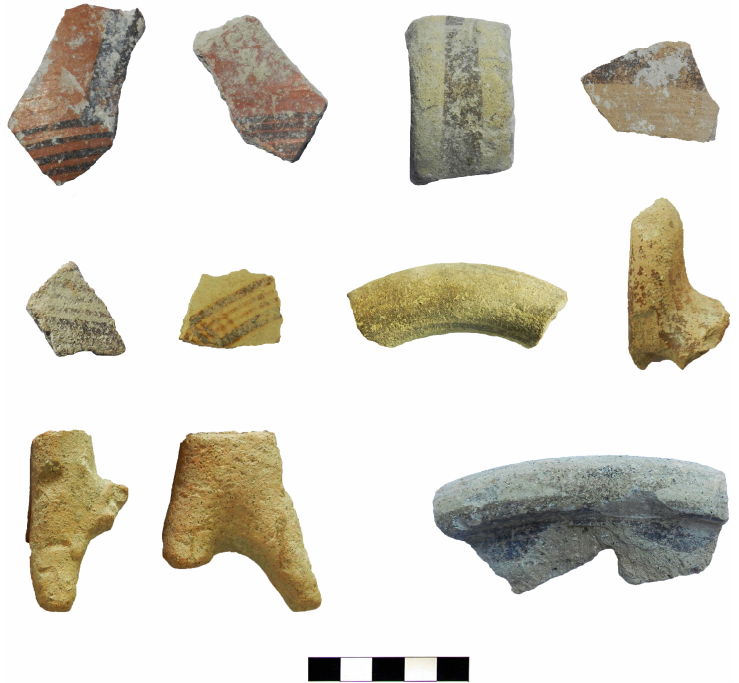
Figure 14. Iron Age pottery and terracotta figurines from the site of Kophinou-Panagia in the Xeros River valley (Image by Athanasios K. Vionis).